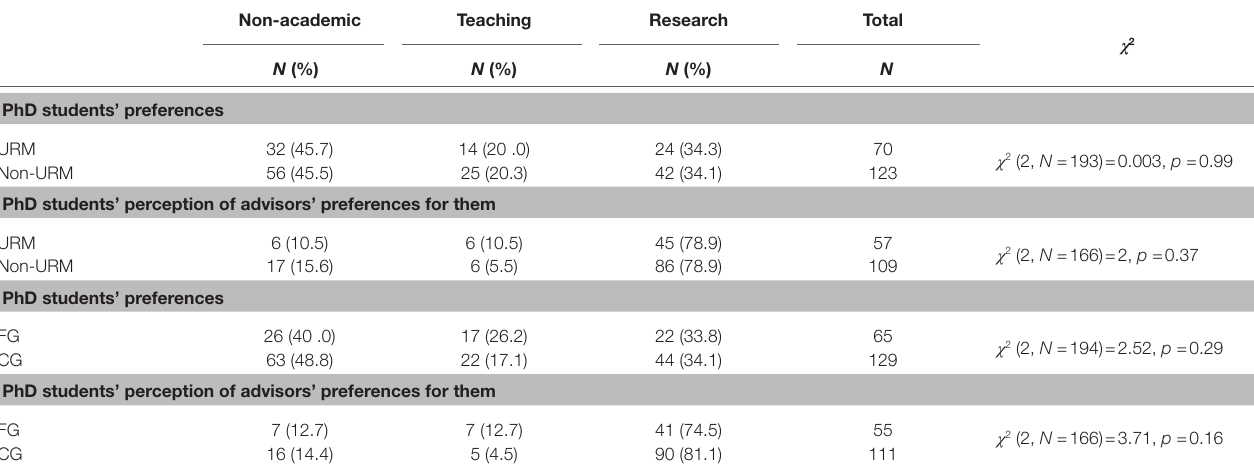
TABLE 3 | PhD students’ own and perception of advisors’ preferences for them by demographic